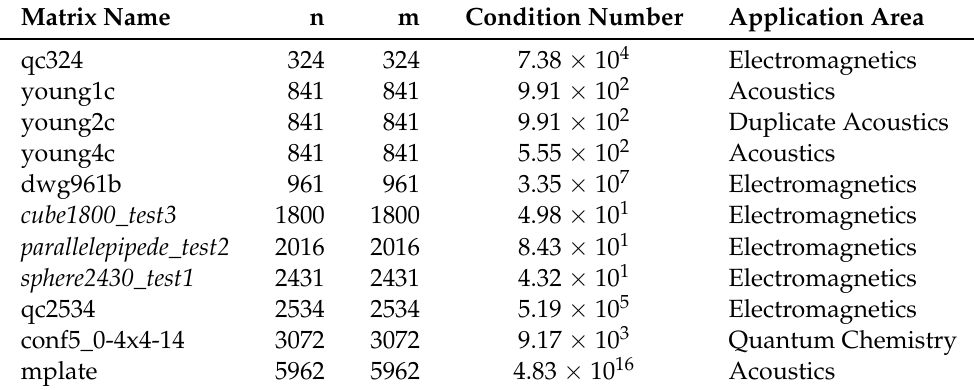
Table 2. Summary of used real-life problems. Matrices marked by italic font come from the SWUFE- Math Test Matrices Library, while non-italicized matrices come from the SuiteSparse matrix